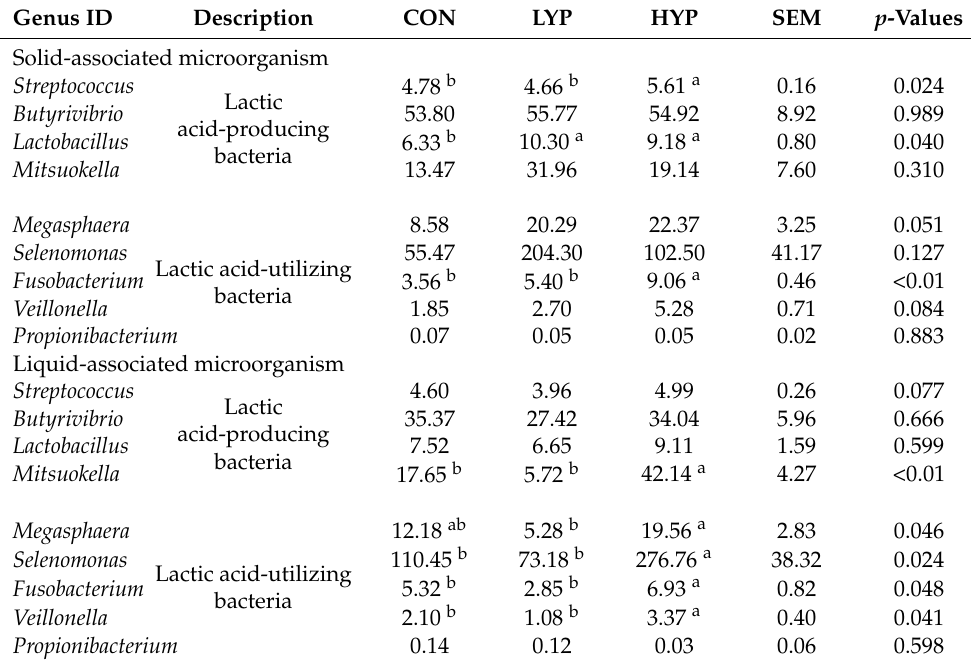
Table 3. Effects of yeast product on the relative abundance of microorganisms related to lactic acid metabolism. Genus